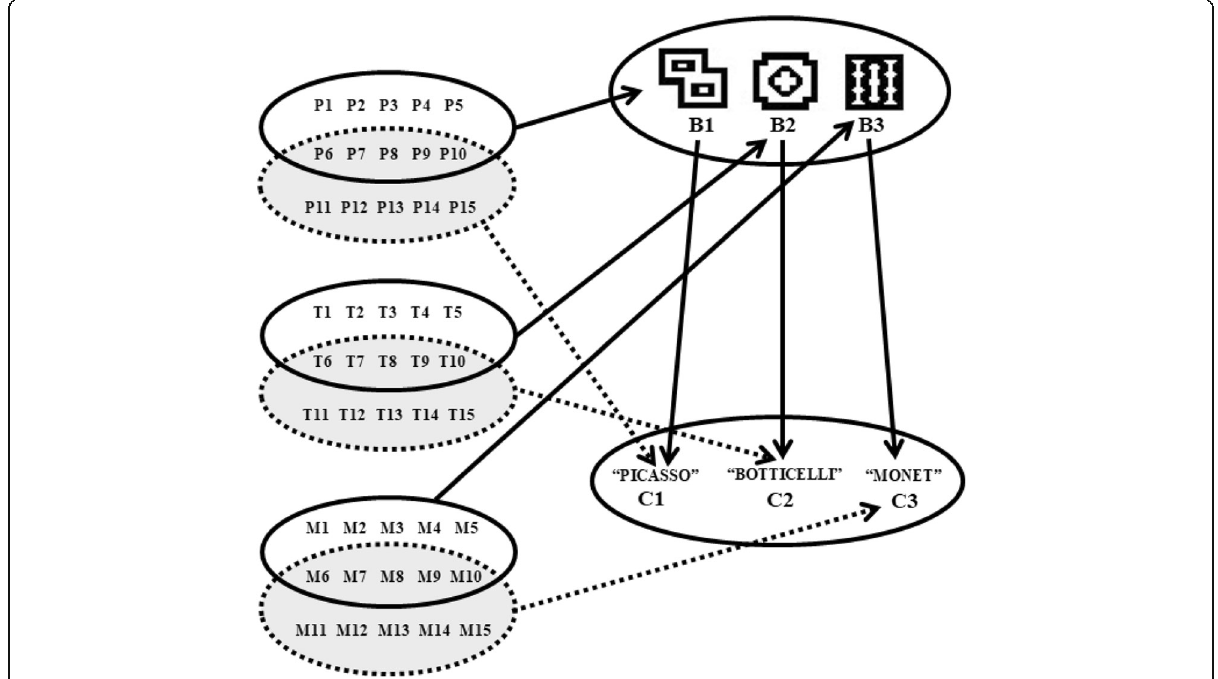
Fig. 2 The diagram represents all the trained and tested relations. Ellipses represent sets of stimuli. The continuous arrows indicate training relations and the dashed arrows indicate untrained